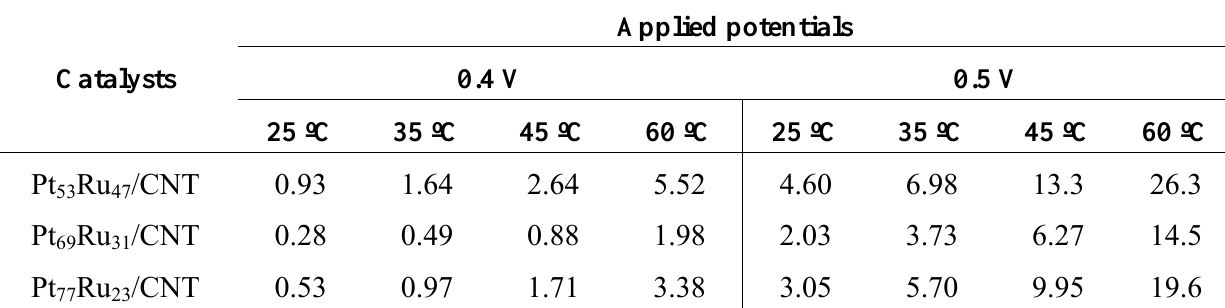
Table 2. Turnover number (molecule s -1 site -1  10 -3 ) of PtRu/CNT catalysts for methanol electro-oxidation at different potentials.